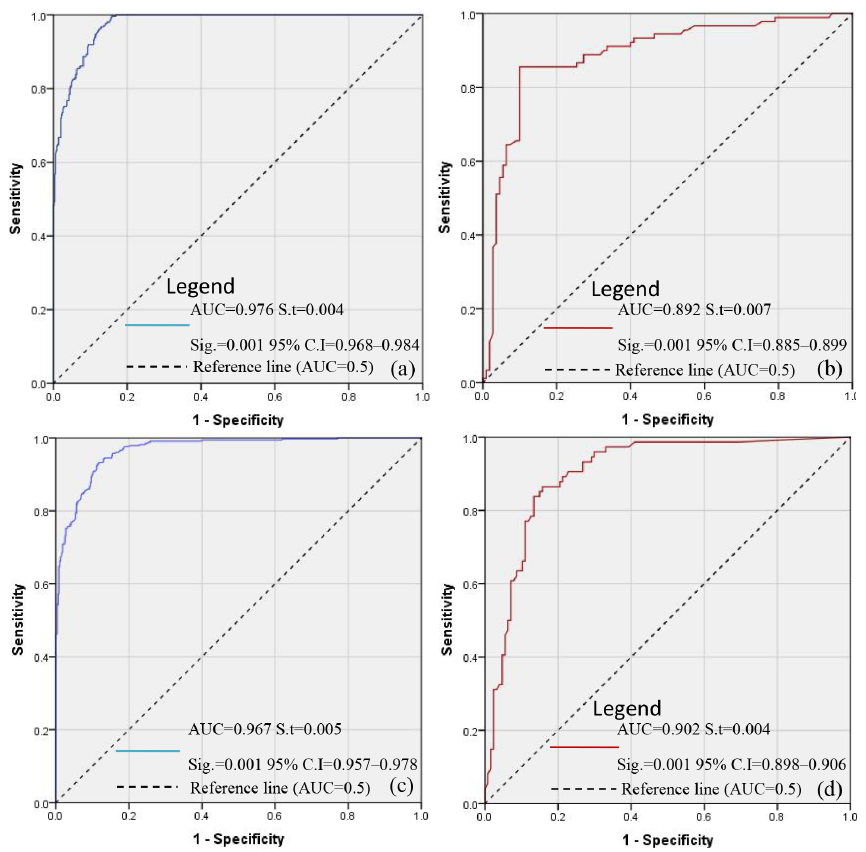
Figure 7. Analysis of the ROC curve for the two susceptibility maps: (a) success rate curve of landslide using the training dataset, (b) pre- diction rate curve of landslide using the validation dataset, (c) success rate curve of debris flow using the training dataset, and (d) prediction rate curve of debris flow using the validation dataset. Table 3. Variable importance assigned for landslide. Test Slope Distance Plan Topographic Distance Maximum Profile Elevation group angle to fault curvature wetness to road elevation curvature index difference Landslide 0.21 0.19 0.17 0.13 0.08 0.07 0.06